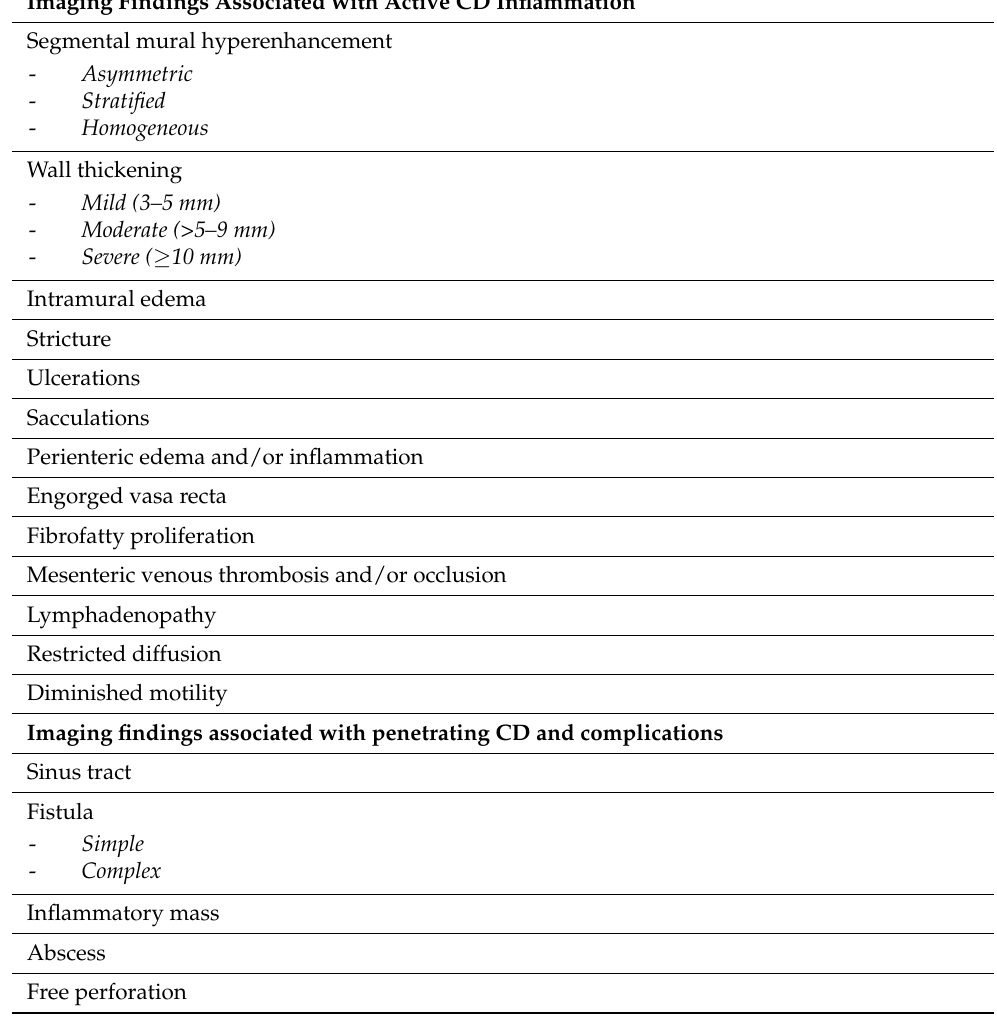
Table 2. Imaging findings associated with active and complicated